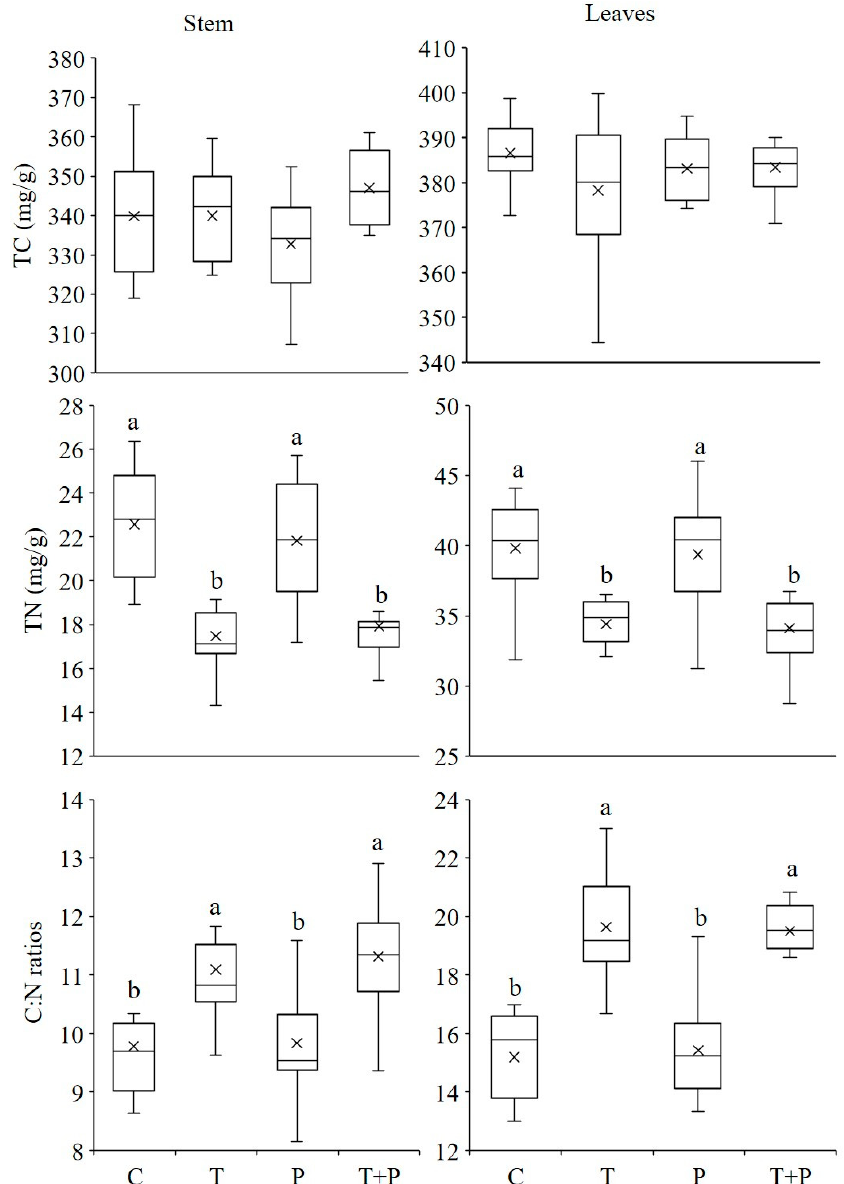
Figure 4. Effect of warming and phosphorus addition on plant total carbon and nitrogen concentrations and carbon: nitrogen ratios in May 2014. Different letters (a, b, c) indicate significant ( p < 0.05) differences. Error bars indicate ± standard error (SE). For abbreviations used, see Figure 2.